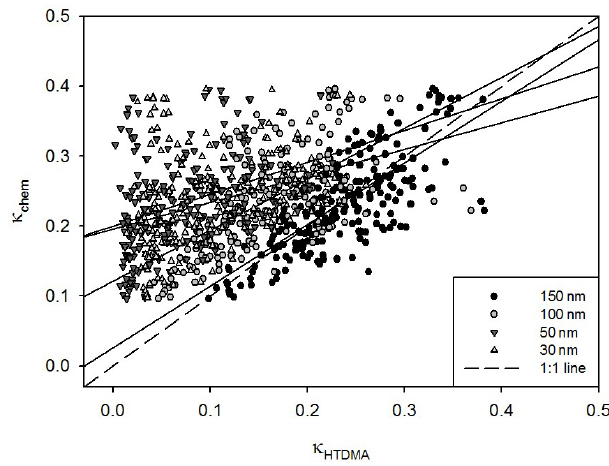
Figure 4. Scatterplot between κ HTDMA and κ chem for four different diameters. The dashed line and solid line indicate the 1:1 line and linear regression line,